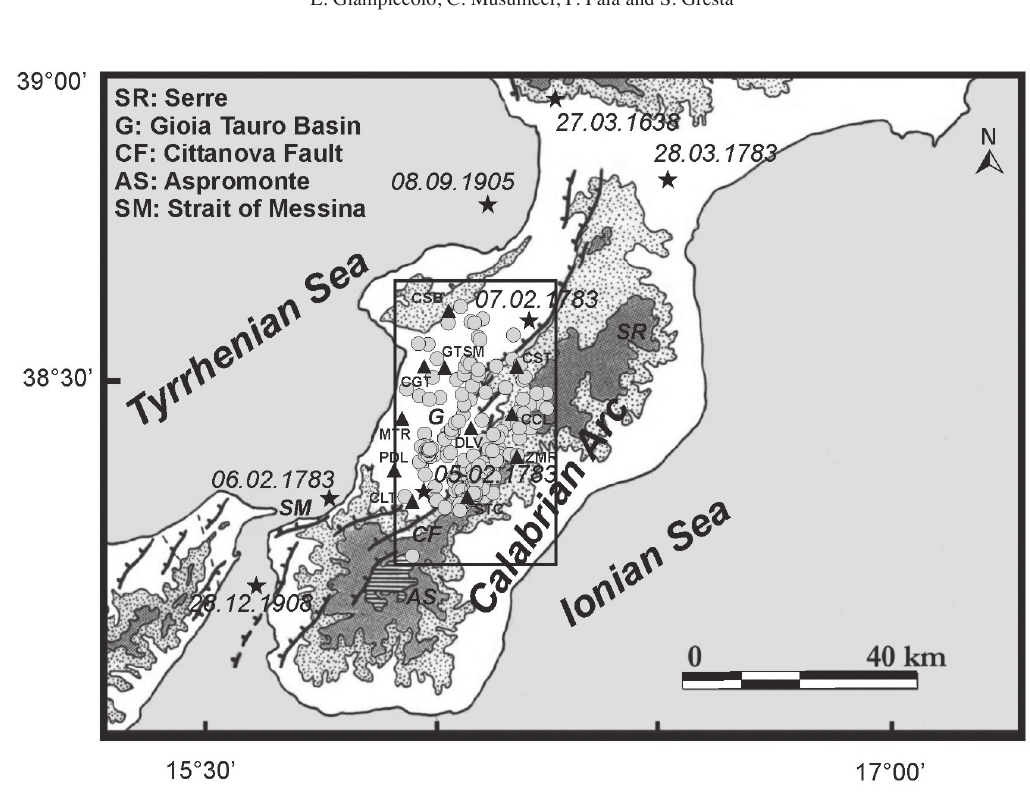
Fig. 1. Map of the study area (modified after Tortorici et al. , 1995) showing the location of the events selected in this study (grey circles inside the black rectangle). Historical earthquakes are also shown (stars). Triangles represent the stations of the seismic network operating from 1985 to